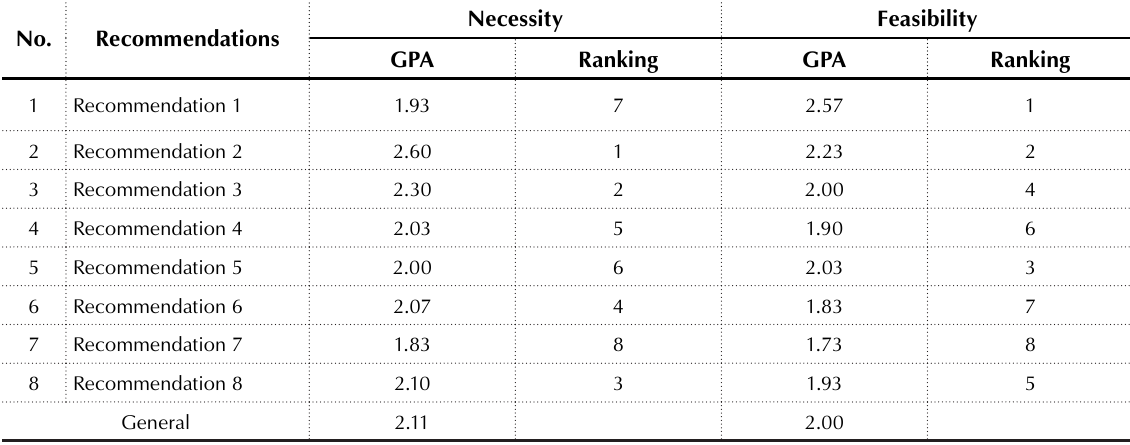
Table 6. Expert survey results on the feasibility and necessity of management recommendations No.